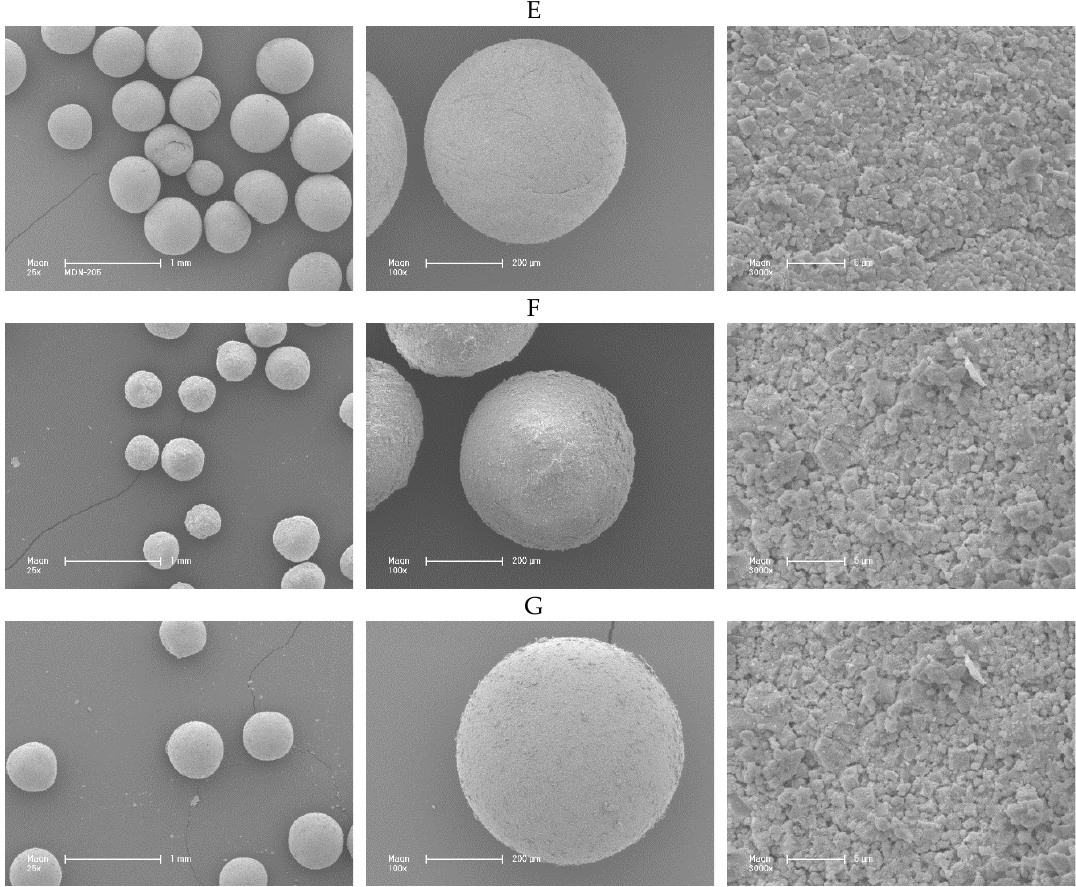
Figure 4. SEM images of MSA-1 resin ( A ) and ZK-4 beads synthesized at different temperatures and different treatment times: ( B ) 70 °C, 7 days, ( C ) 100 °C, 7 days, ( D ) 150 °C, 24 h, ( E ) 160 °C, 24 h, ( F ) 170 °C, 24 h and ( G ) 180 °C, 24 h.